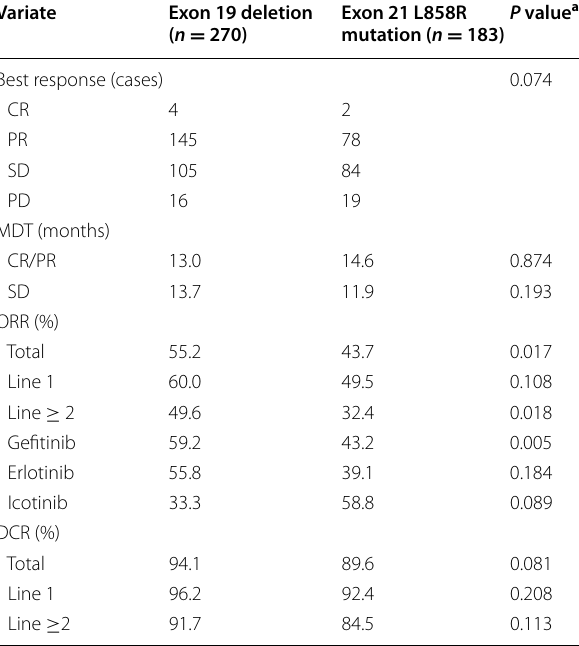
Table 2 Response to EGFR-TKIs in 453 NSCLC patients with different EGFR